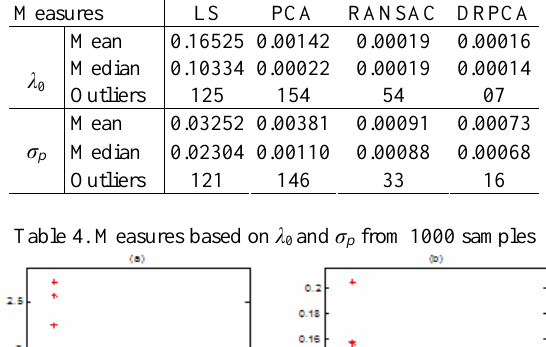
Figure 7. Box-plots of (a) λ 0 (b) σ p